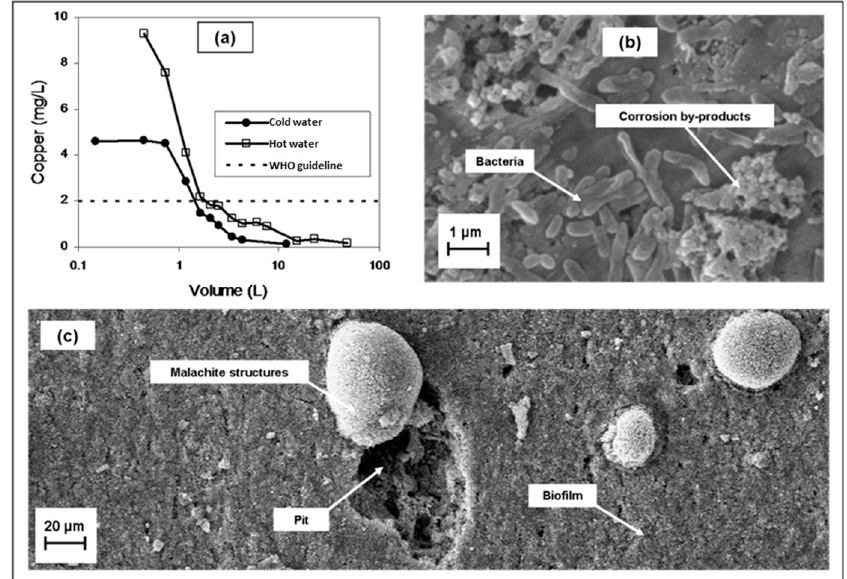
Figure 2. A copper pipe system affected by Microbiologically Influenced Corrosion (MIC): ( a ) copper release measurements; ( b ) Scanning Electron Microscopy (SEM) image of a biofilm formed on the pipe inner surface; and ( c ) SEM image of a pipe under MIC.